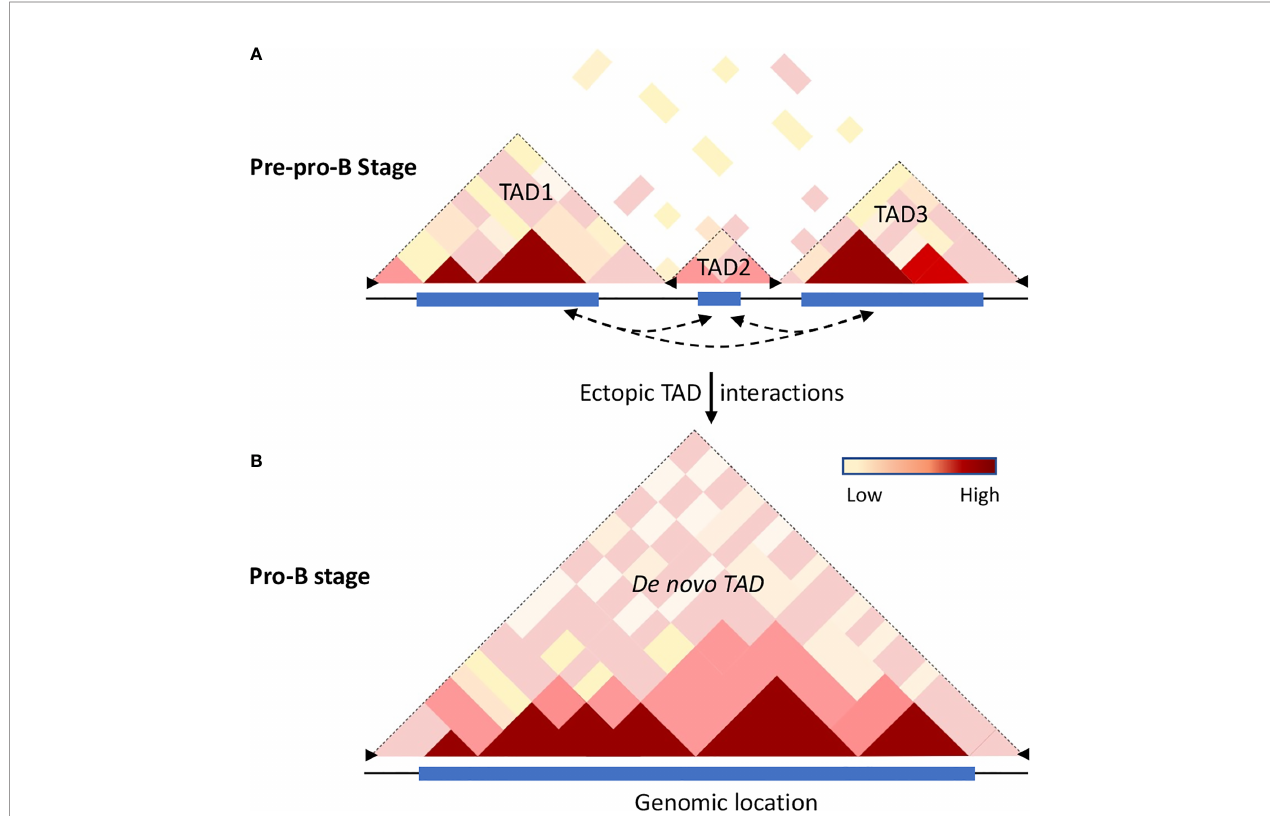
FIGURE 2 | Chromatin dynamics in B cell progenitors. Hi-C analysis revealed that the mammalian genome is organized into topologically associated domains (TADs), generated by aggregation of self-interaction chromatin regions that feature similar properties, permissive or repressive, respectively. TADs are separated from each other by boundary elements that restrain interactions with adjacent TADs. The boundary elements are enriched with insulator proteins cohesin and CTCF. (A) The cartoon illustrates the Hi-C interactome of the mouse chromosome 12 for a genomic region that is partitioned into multiple TADs at the pre-pro-B cell stage. The frequency of intra-chromosomal interactions is indicated by the color gradient. (B) Schematic representation of the extended TAD of the same genomic region observed in committed B cells (57). During differentiation transcribing regions establish strong ectopic-TAD chromatin interactions leading to the merging of multiple adjacent TADs into a single de novo TAD. The increased cis-regulatory interactions within and between the TADs may be accomplished by loss of insulator proteins at the boundary regions accompanied by binding of TFs to their cognate regulatory elements thereby promoting alterations in genome con fi rmations. Dotted arrow lines represent possible ectopic-TAD interactions, blue rectangles represent genome scale high-frequency Hi-C interactions, and black arrowheads represent boundary